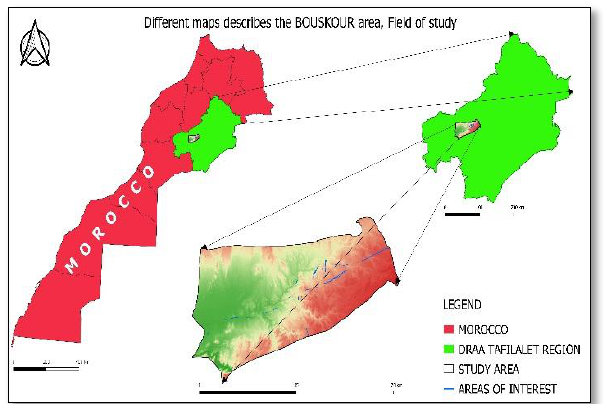
Figure 1: Overview map of Bou Skour study